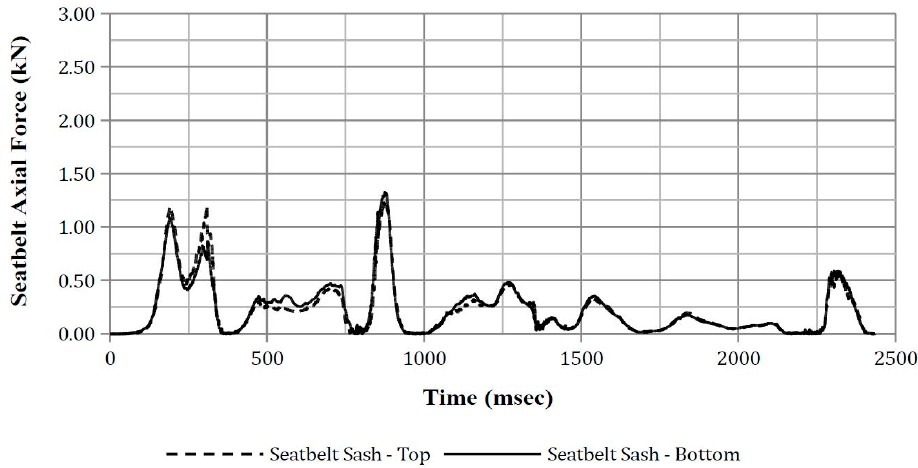
Figure A37. ATD Position 8 sash belt axial force.